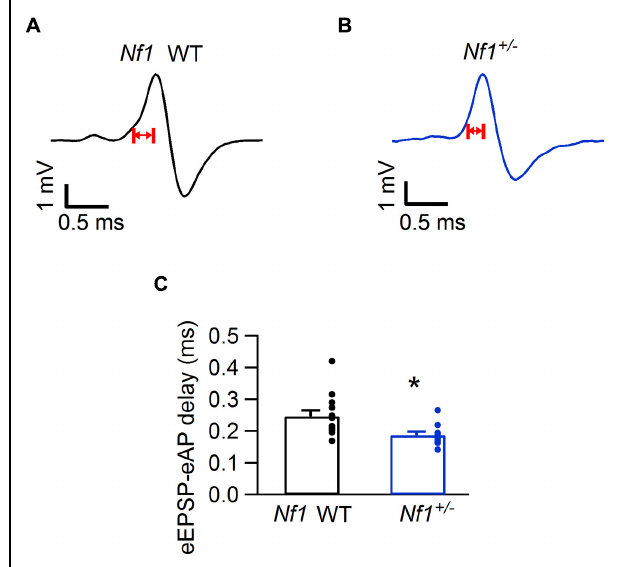
FIGURE 3 | Decreased eEPSP-eAP delay in Nf1 + / − mice. (A) Representative juxtacellular complex waveform from a Nf1 + / + (wild-type) mouse. Red arrows indicate the eEPSP-eAP delay. (B) Same as (A) , but from a Nf1 + / − mouse. (C) Comparison of eEPSP-eAP delay of medial nucleus of the trapezoid body (MNTB) neurons between Nf1 + / + wild-type (black) and mutants (blue). Significant difference is indicated with ∗ . Error bars indicate SEM; individual data points are shown as small filled circles.